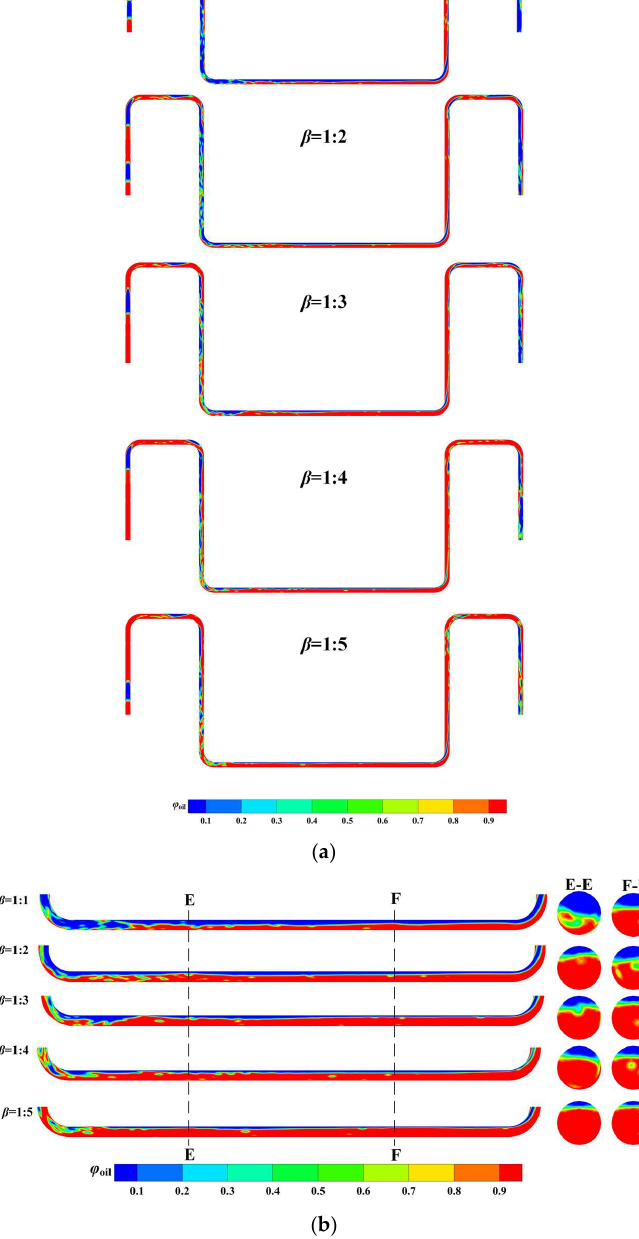
Figure 13. Comparison of flow regimes at different gas-liquid ratios, where φ gas is the gas void frac- tion, β is the gas-liquid ratio, and E-E and F-F denote two selected cross-sections along the bottom horizontal tube: ( a ) flow regimes in the jumper when the periodically stable flow is achieved; ( b ) contours of oil volume fraction in the bottom tube and the zoom-in view of two considered cross- sections.